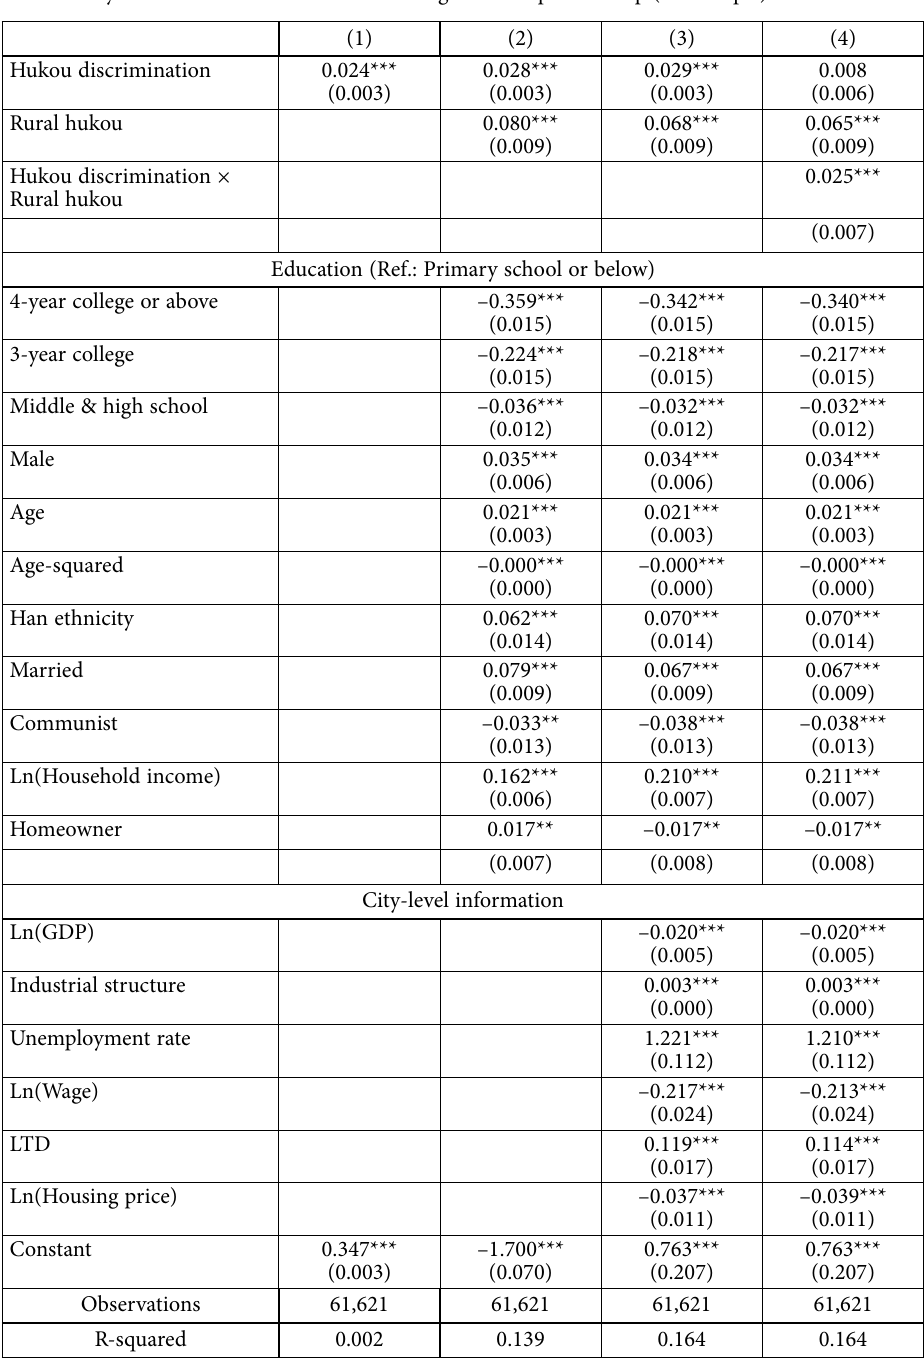
Table 3. City-level hukou discrimination and migrant entrepreneurship (full